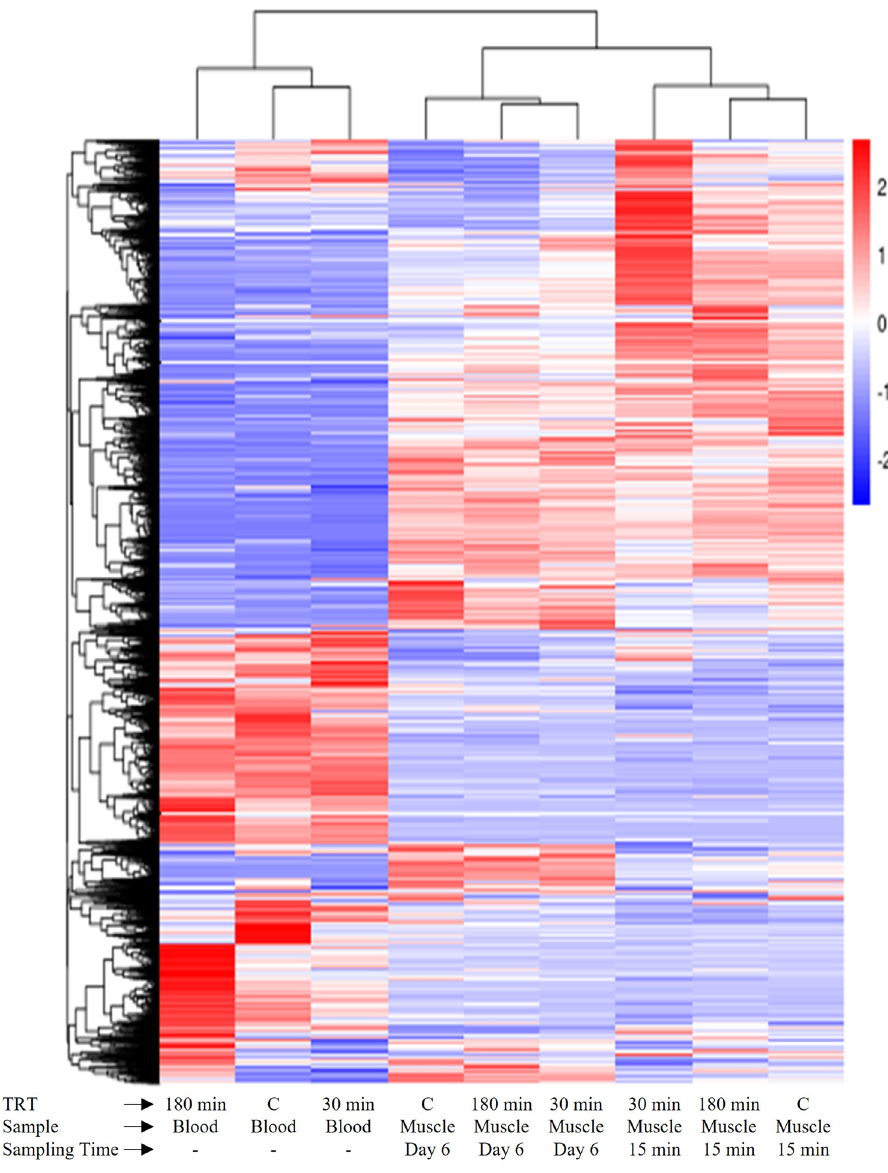
Figure 5. Heat map of blood samples from goats subjected to stress treatments (TRT: control, C = not transported but held in pens; 30 min = transported for 30 min; or 180 min = transported for 180 min) and of meat samples ( Longissimus dorsi ) at 15 min postmortem or after 6